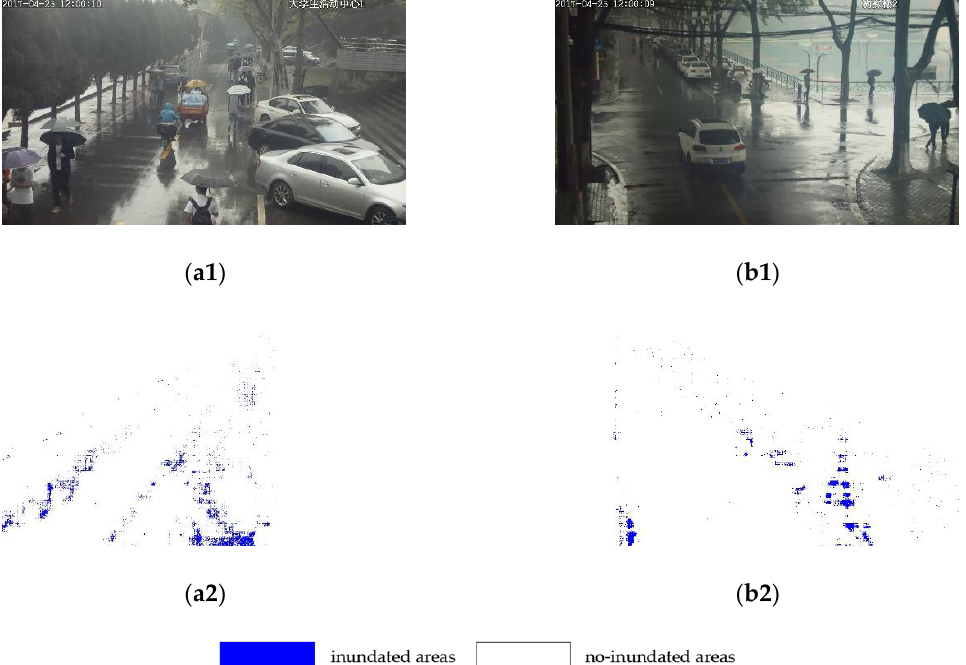
Figure 13. The extraction of the wet videos: Origin images ( a1 , b1 ) and Results ( a2 , b2 ).